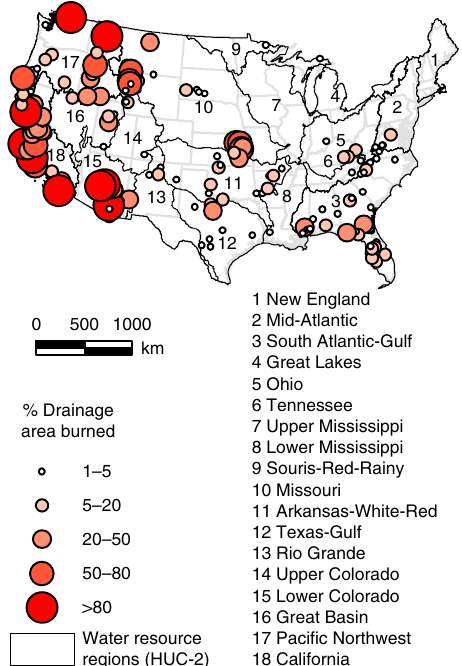
Fig. 2 Ratios of watershed area burned to watershed drainage area. Shown are US watersheds burned between 1985 and 2008 ( n = 168 burned watersheds with BAR ≥ 1%)